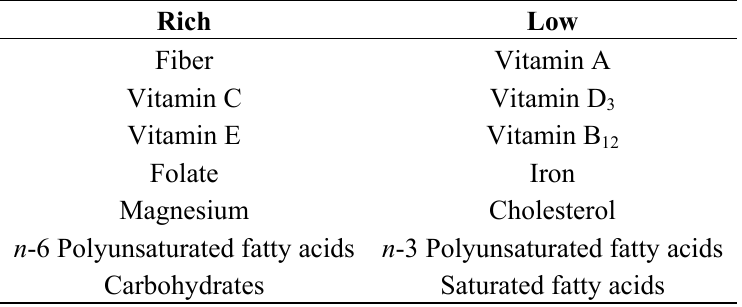
Table 1. Nutrient imbalance in vegetarian